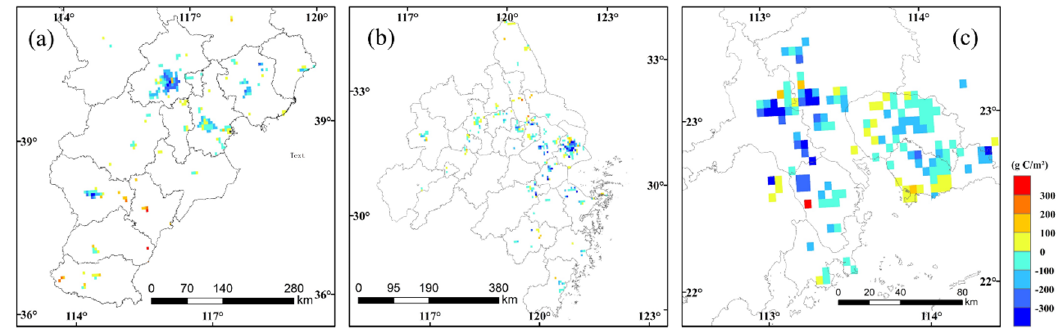
Figure 7. NPP difference between 1982 and 2015 in ( a ) the BTHUA, ( b ) the YRDUA, and ( c ) the PRDUA within urban lands in 2015.